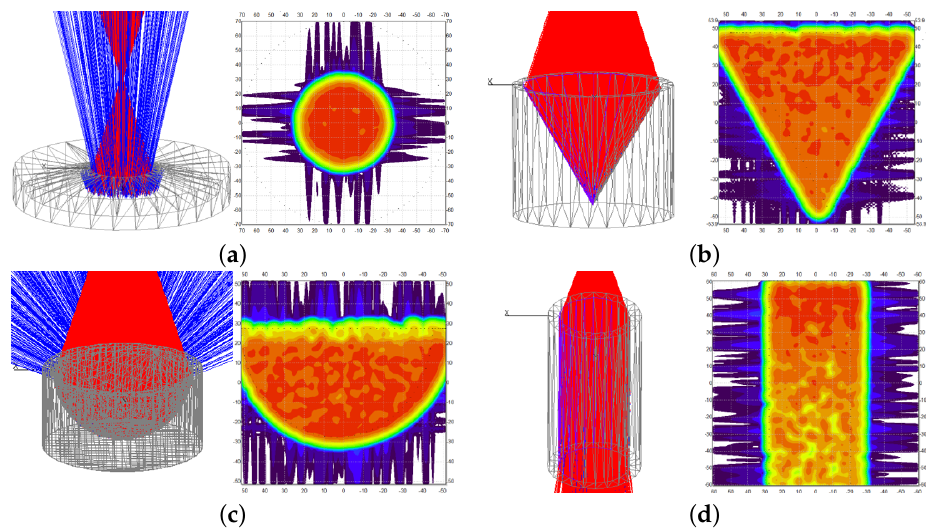
Figure 16. Sunlight absorption of different shapes: ( a ) positive conical (Base diameter 154 mm, aperture diameter 45 mm, base surface absorptance 85%, lateral surface reflectivity 80%); ( b ) negative conical (aperture diameter and slant height 110 mm, surface absorptance 85%); ( c ) hemispherical (aperture diameter 110 mm, surface absorptance 85%); ( d ) cylindrical through (aperture diameter 50 mm, cavity height 121 mm, surface absorptance 85%). Incoming flux 1 kW, focus adjusted at 0.5 mm intervals.